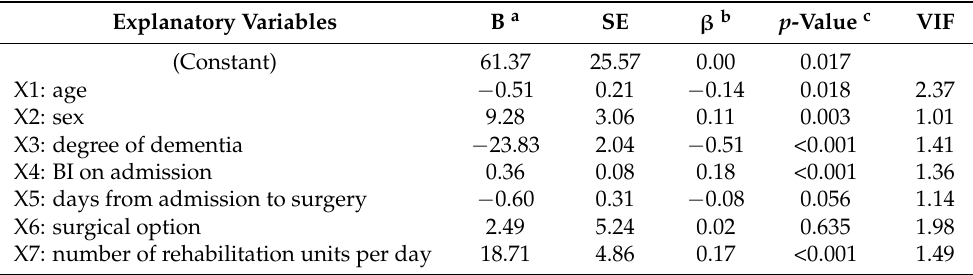
Table 2. Multiple regression analysis.